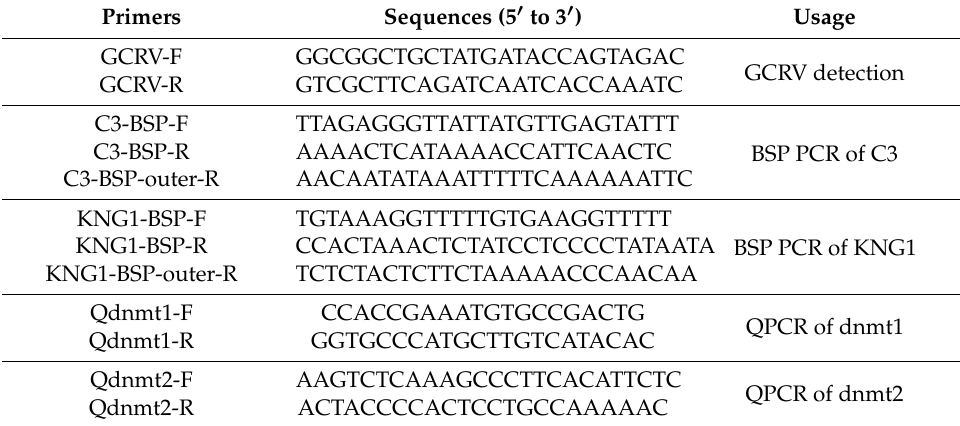
Table 1. Primers used in the